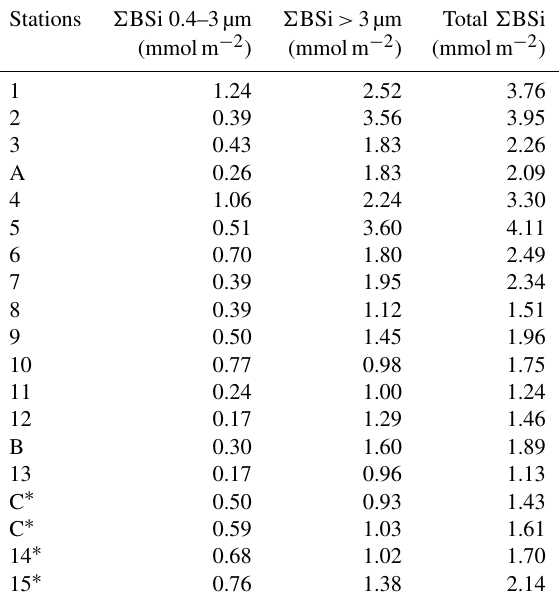
Table B1. Integrated size-fractionated biogenic silica concentrations ( (cid:54) BSi) in the southwestern Pacific (OUTPACE cruise) over 0–125m (0–200m for ∗